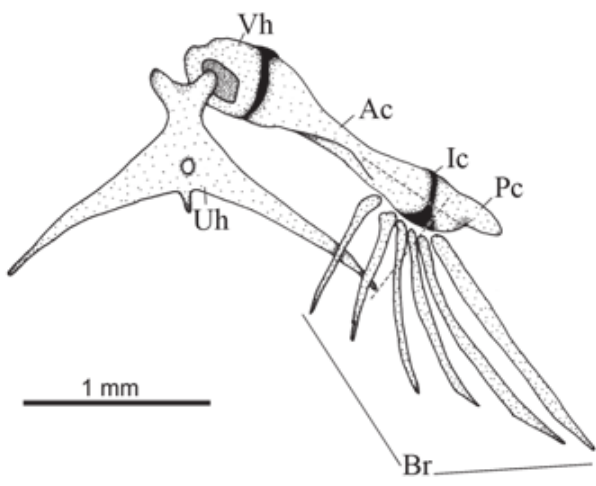
Fig. 4. Hyoid arch of Listrura costai , new species, UFRJ 6577, paratype, 34.3 mm SL, left side: ventral view. Dashed lines indicate the tip of the lateral process of urohyal in relation to ceratohyals. Ac - anterior ceratohyal; Br - branchiostegal rays; Ic - interceratohyal cartilage; Pc - posterior ceratohyal; Uh - urohyal; Vh - ventral